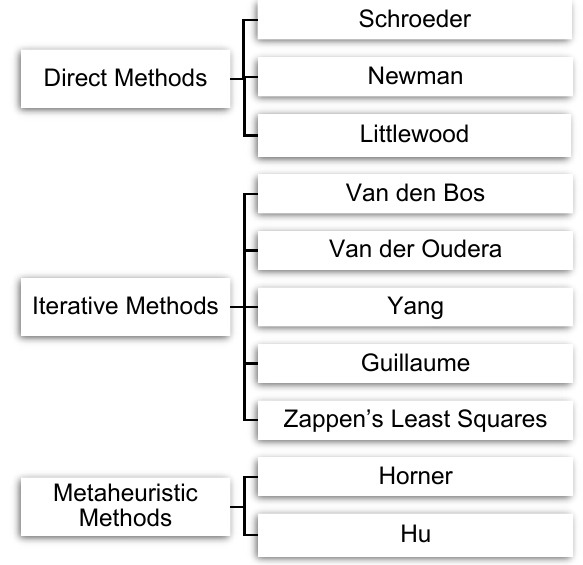
Figure 3. Overview of crest factor optimization methods for multisine